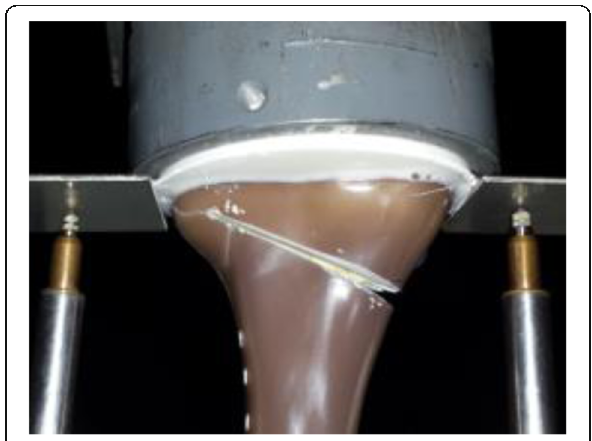
Fig. 6 Cracking of the contralateral cortex during the cyclical testing: Unlike the case of Activmotion 4 showed on the picture, the cracking was generally not